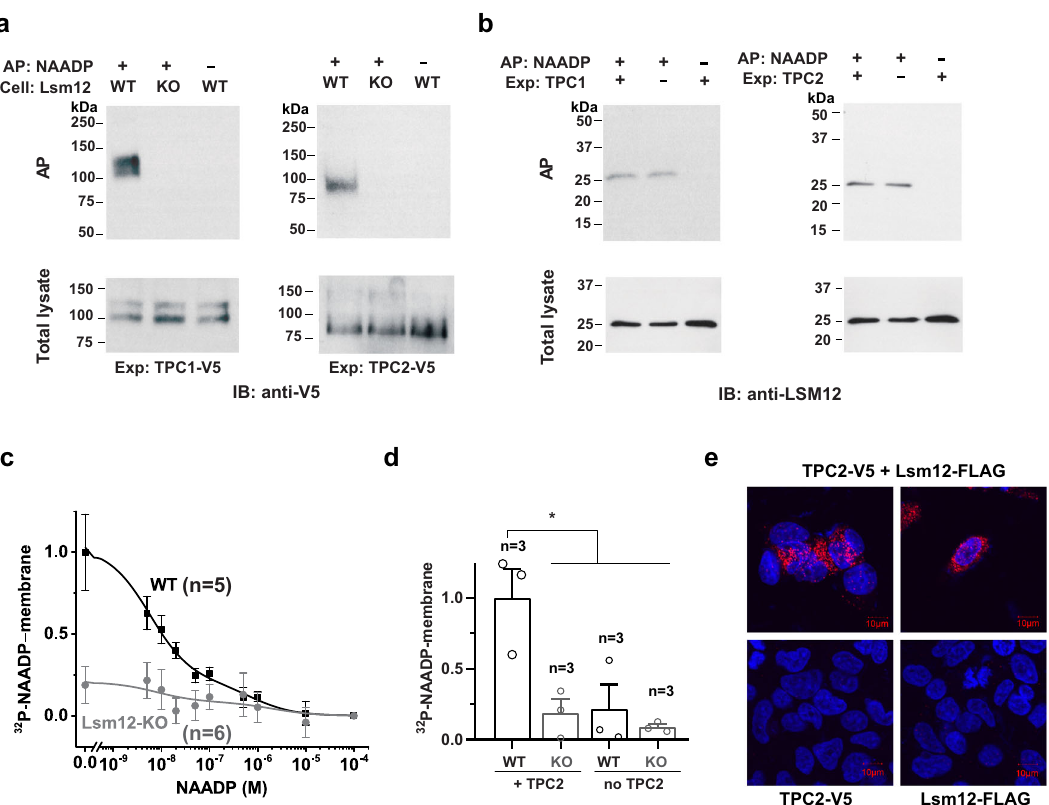
Fig. 5 Lsm12 mediates the apparent association of NAADP to TPC2 and cell membranes. a Immunoblot of TPC1 and TPC2 pulled down by immobilized NAADP from TPC1- and TPC2-expressing HEK293 WT and Lsm12-KO cells. b Immunoblot of Lsm12 pulled down by immobilized NAADP from cells with/ without exogenous TPC1 and TPC2 expression. c Competition radioligand binding assay of the association between 32 P-NAADP and TPC2-expressing cell membranes in the presence of various concentrations of non-radiolabeled NAADP. d Speci fi c binding of 32 P-NAADP to cell membranes in WT and Lsm12- KO cells with/without exogenous TPC2 expression. e In situ PLA of TPC2 and Lsm12 colocalization in HEK293 cells. Top panels show cells expressing both exogenous TPC2 and Lsm12 and bottom panels show cells expressing only one of them. AP af fi nity precipitation, Exp expression, AP: NAADP± AP with/ without immobilized NAADP. Data were presented as mean value ± SEM. Unpaired Student ’ s t -test (two-tailed) was used to calculate p values. * is for p values ≤